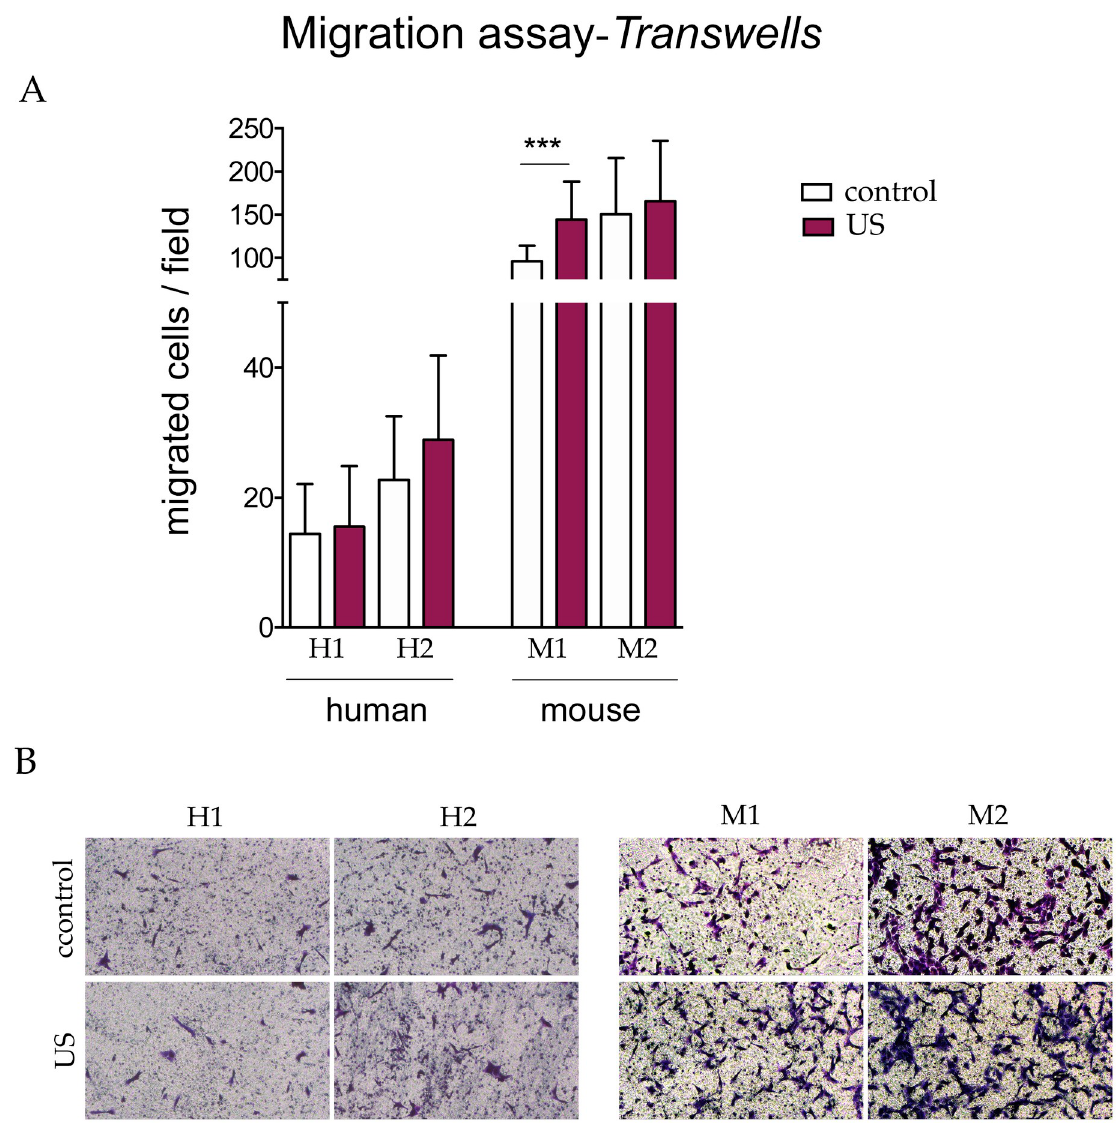
Fig 6. Transwell migration assay. (A) Data are shown from a representative experiment out of three performed and denote mean ± SD. Statistical analysis was performed using Student’s t test. ��� p < 0.001. (B) Representative images (10 × ) of the migrated cells. Shown are two independent samples of mouse (M1 and M2) and human (H1 and H2) s-MPs under control conditions or treated with ultrasound